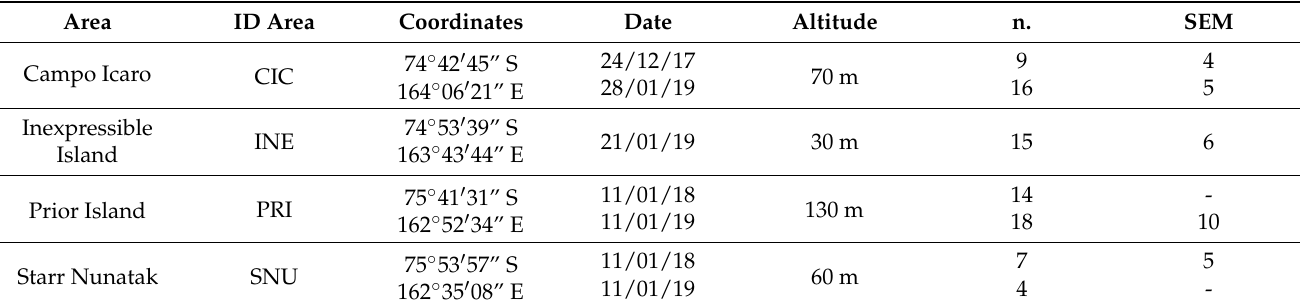
Table 1. Sampling location details including respective area codes and coordinates, the date of collection, the altitude of the sampling site and numbers of the specimens prepared for optical microscopy (n.) and scanning electron microscopy (SEM). Area ID Area Coordinates Date Altitude Campo